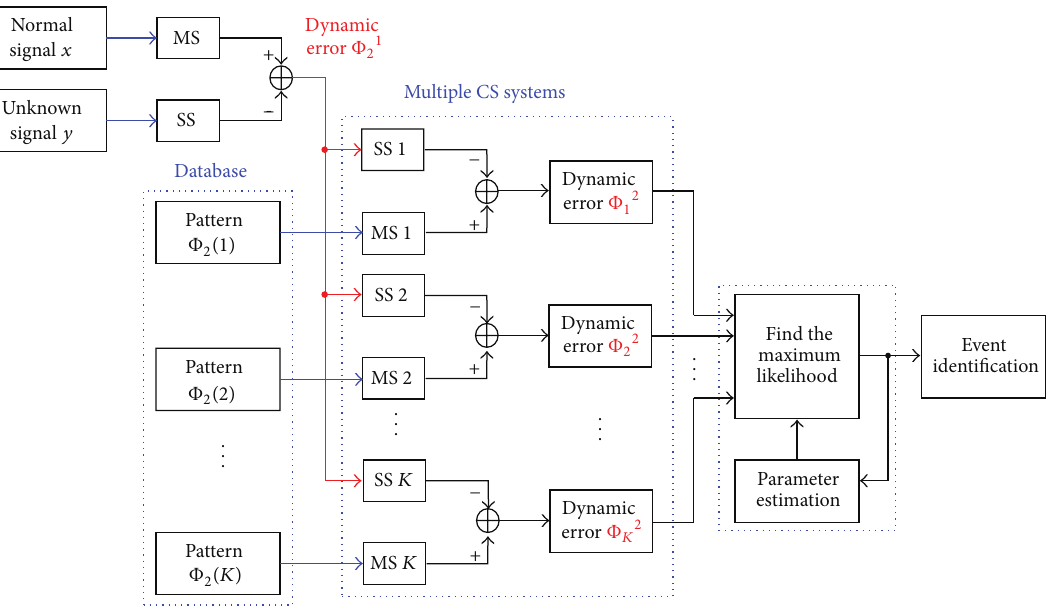
Figure 1: Architecture of multiple chaos synchronization (CS) systems.